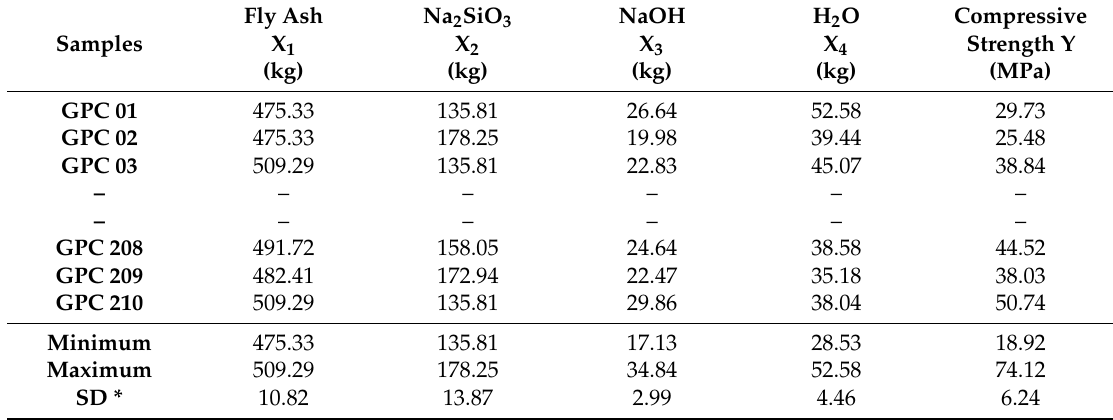
Table 1. Mix proportion of geopolymer concrete (GPC) using steel slag